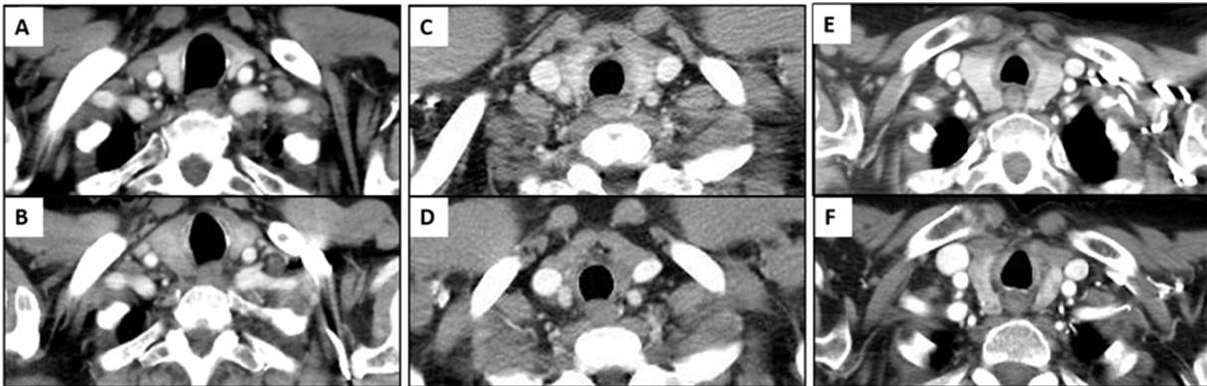
Figure 2. Imaging findings of immune-related thyroiditis from chest CT scan. ( A , B ) A 75-year-old